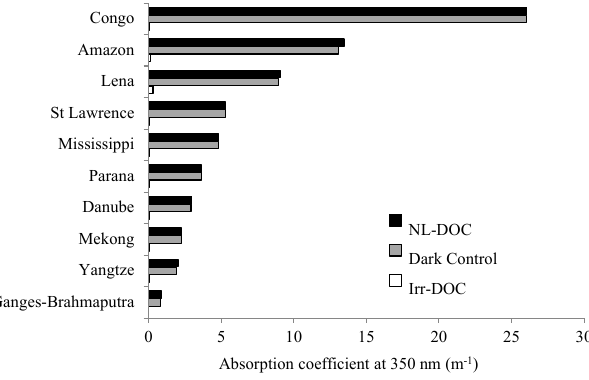
Figure 2. Absorption coefficient of chromophoric DOM at 350nm in the samples before (initial NL-DOC, black) and after the irradia- tion experiment (irr-DOC, white) and the dark controls (grey).